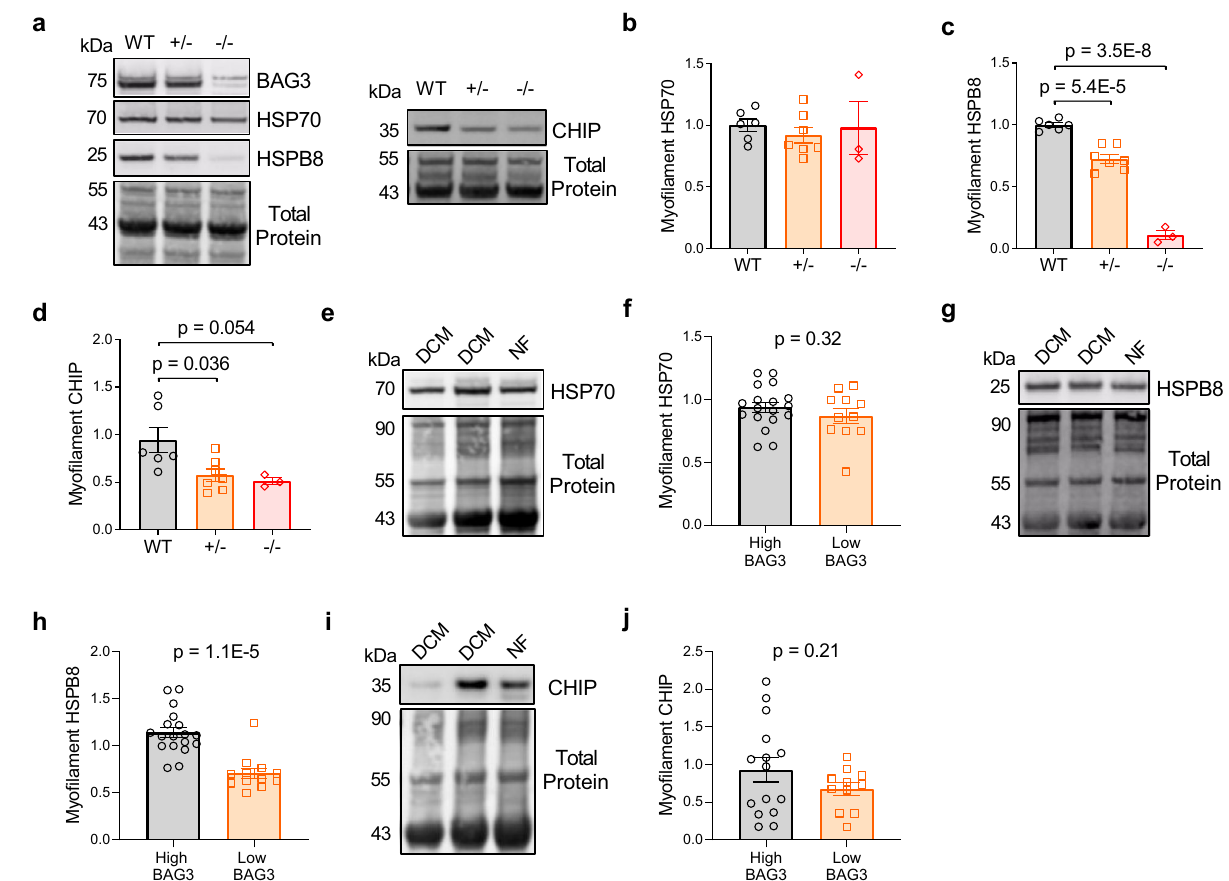
Fig. 5 BAG3 is required for full assembly of CASA complex members in the myo fi lament fraction. a Western blots for myo fi lament BAG3, HSP70, HSPB8, and CHIP in WT, BAG3 + / − , and BAG3 − / − mice; images are representative of 6 WT hearts, 7 BAG3 + / − hearts, and 3 BAG3 − / − hearts. b – d Densitometry signal of HSP70 ( b ), HSPB8 ( c ), and CHIP ( d ) normalized to total protein; n = 6 WT, 7 BAG3 + / − , 3 BAG3 − / − ; one-way ANOVA, Tukey post-hoc. e Western blot for myo fi lament HSP70 in DCM and NF human samples; image is representative of 9 NF hearts and 21 DCM hearts. f HSP70 expression grouped by “ high ” or “ low ” BAG3 expression; n = 18 high BAG3, 12 low BAG3. g Western blot for myo fi lament HSPB8 in NF and DCM human samples; image is representative of 9 NF hearts and 21 DCM hearts. h HSPB8 expression grouped by “ high ” or “ low ” BAG3 expression; n = 18 high BAG3, 12 low BAG3. i Western blot for myo fi lament CHIP in DCM and NF human samples; image is representative of and 9 NF and 17 DCM hearts. j CHIP expression grouped by “ high ” or “ low ” BAG3 expression; n = 15 high BAG3, 11 low BAG3 (4 samples not assessed due to lack of remaining tissue). High